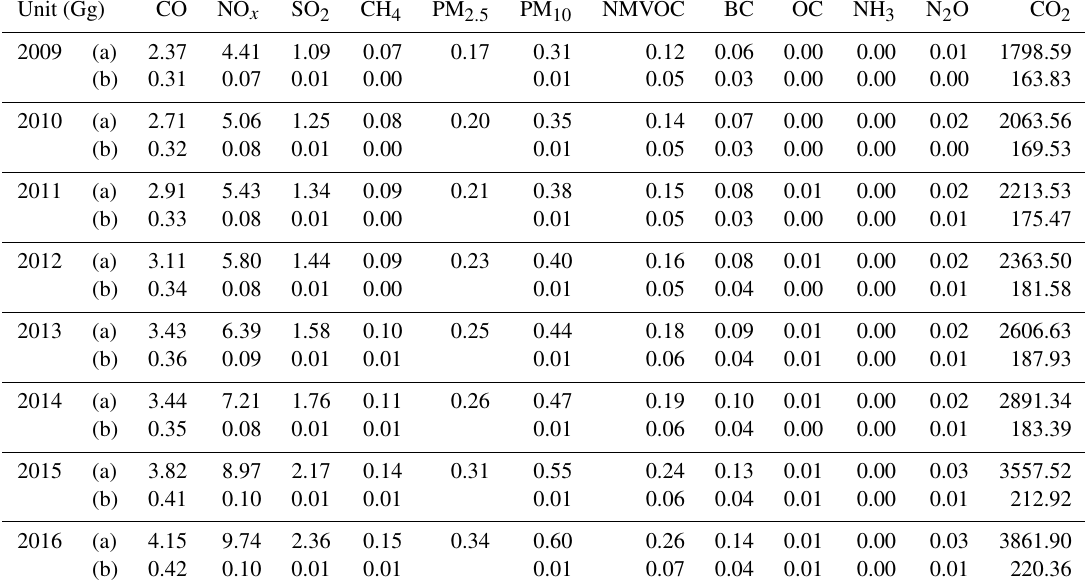
Table 11. Annual emissions from fuel consumption in manufacturing industries and construction (a) and residential buildings (b) (PM 2 . 5 and PM 10 are merged into PM in the residential sector according to ABCEIM by Shrestha et al., 2013). Unit